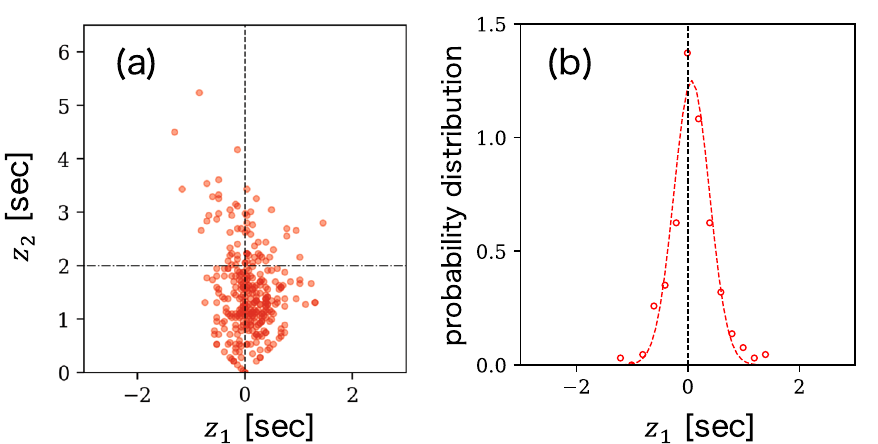
x t e , o ) and (cid:31)